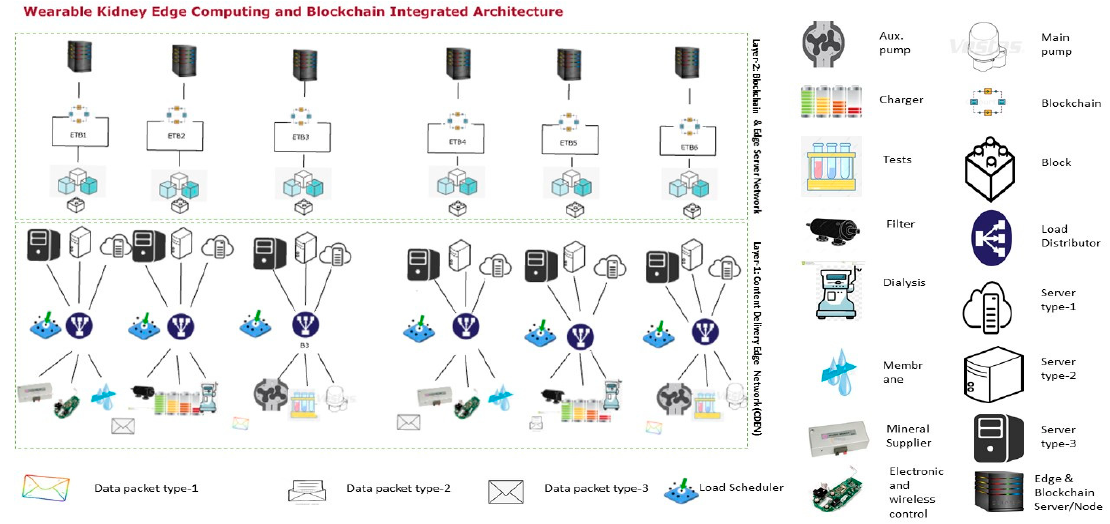
Figure 4. Proposed wearable kidney edge computing with IoT and blockchain technology.